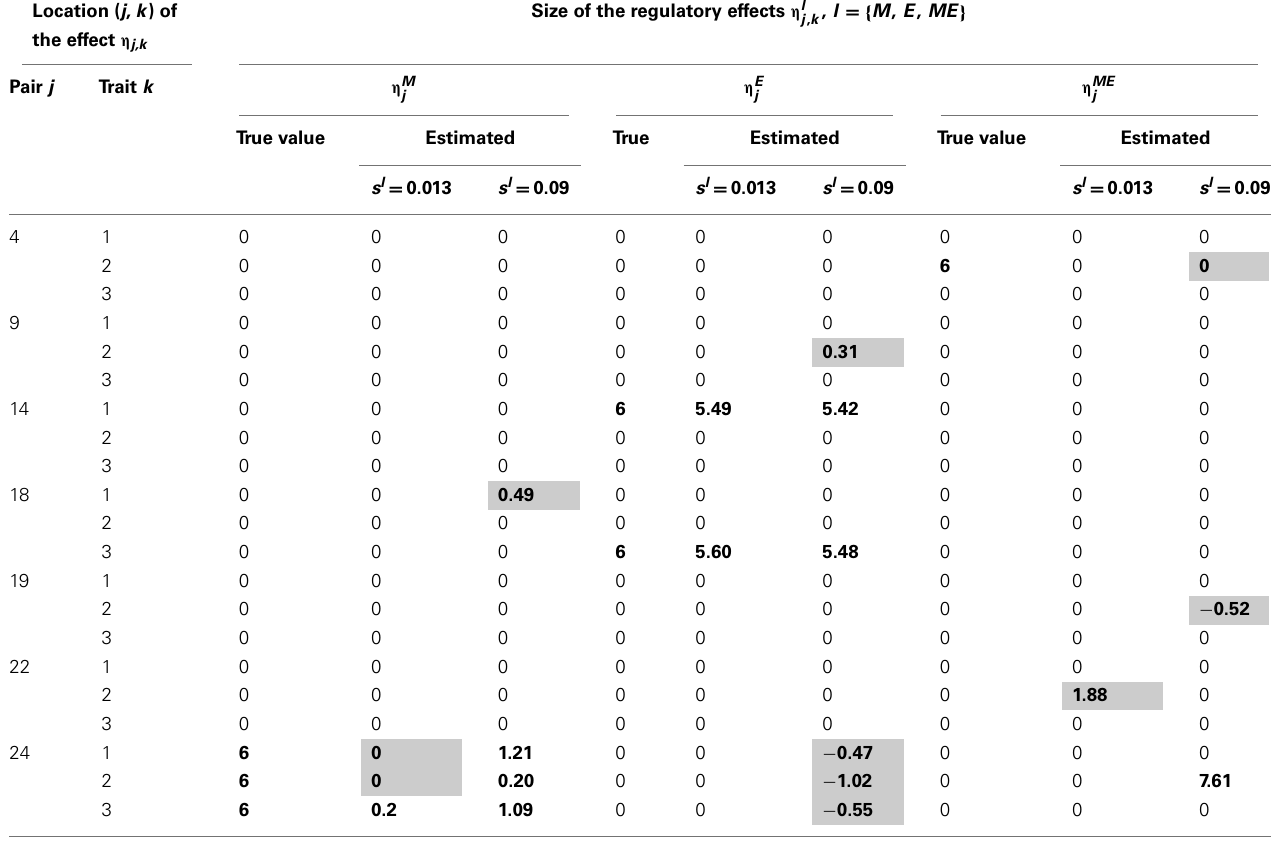
Table 5 |True and estimated (posterior means) cQTL effects under the MD2 version of the HB multi-trait cQTL model with 10% markers and 30% expressions coded as missing and different values of Bernoulli parameter s l . Location ( j , k ) of the effect η